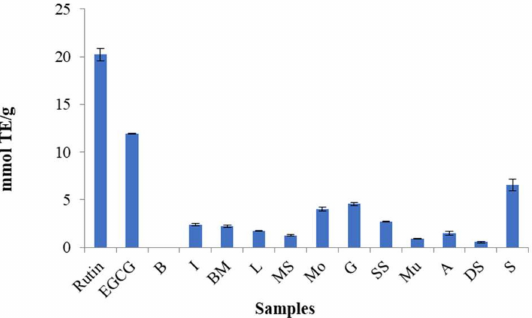
Figure 7. Antiradical capacity of selected Matricaria chamomilla populations in the ORAC